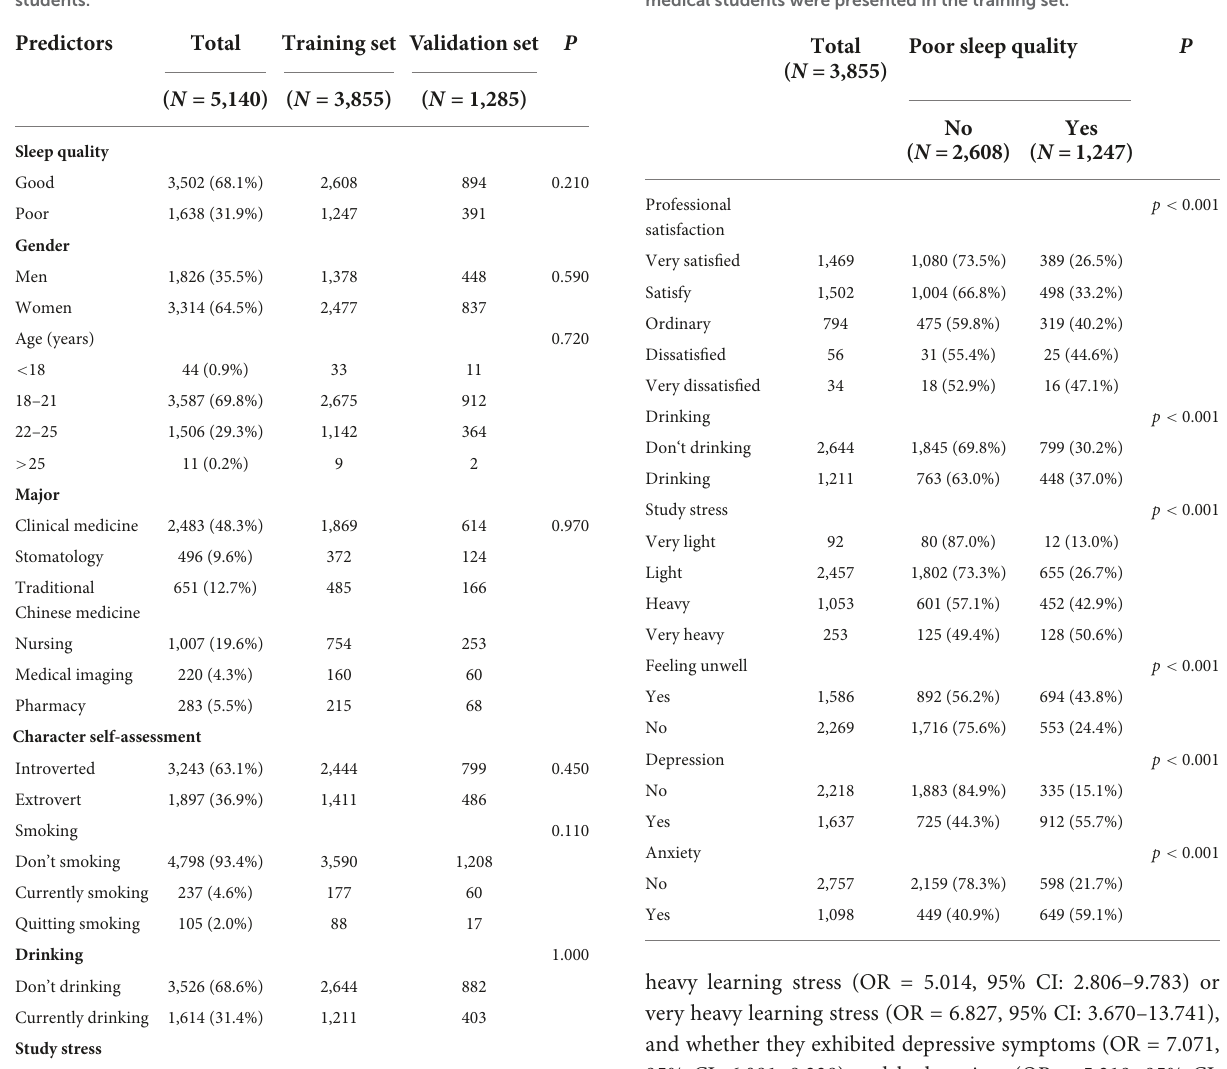
TABLE 1 Demographic and clinical characteristics of medical students.